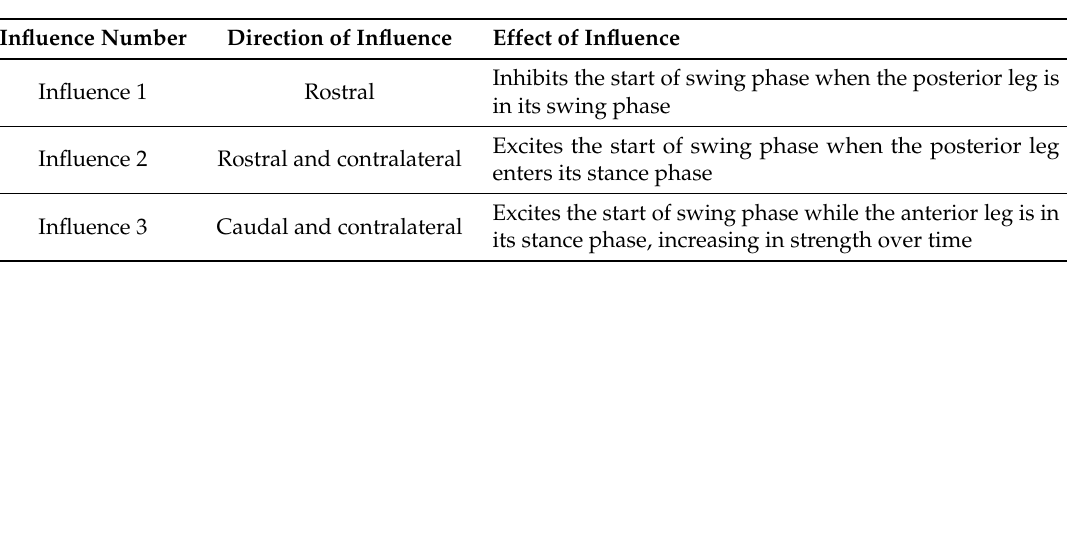
Table 2. Summary of inter-leg